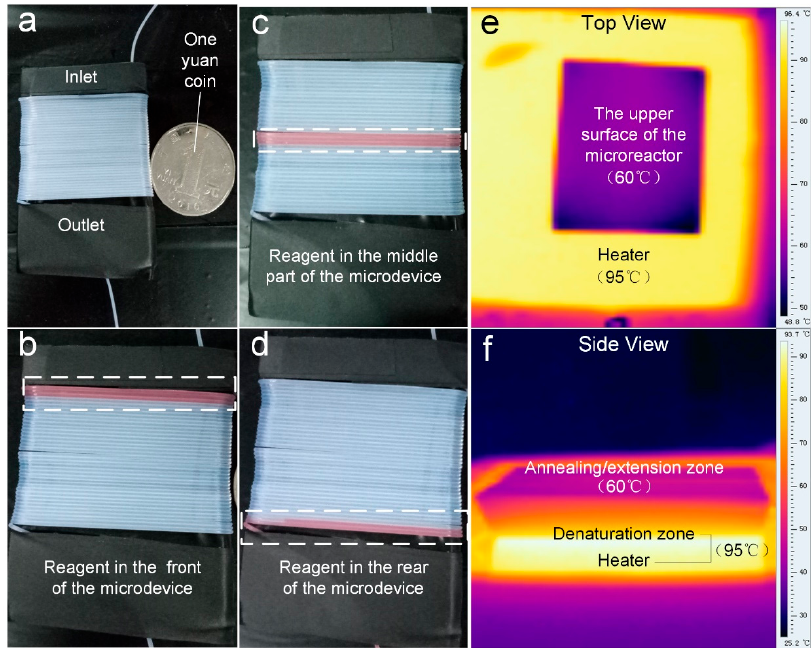
Figure 2. The set-up for continuous-flow on-chip PCR ( a ) with the red-color sample flowing at the start ( b ), the middle ( c ), and the end ( d ) of the fluidic conduit. ( e ) The top view and ( f ) the side view of the thermal infrared image of the trapezoidal PDMS block.